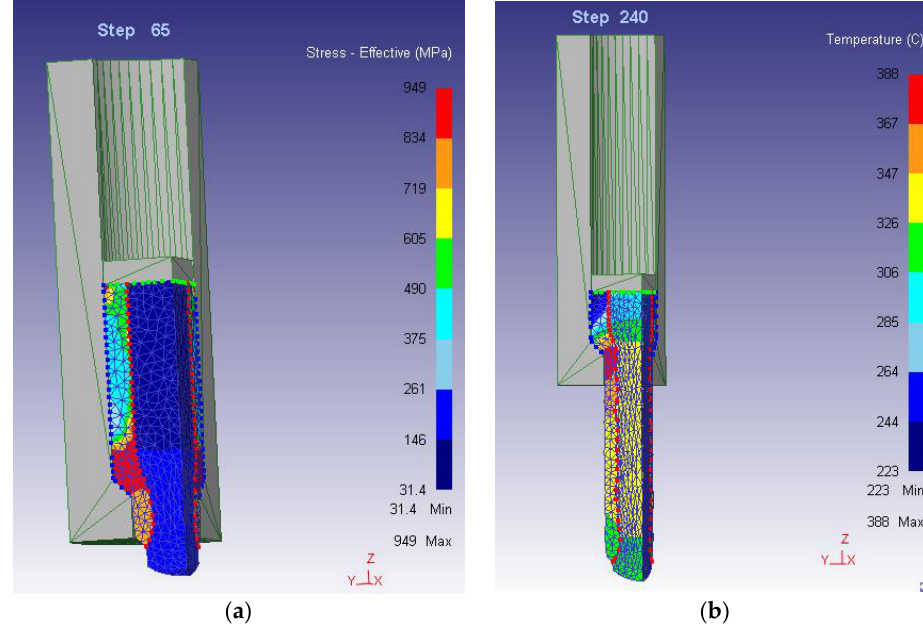
Figure 16. Contour diagrams. ( a ) Effective stress distribution during co-extrusion process; ( b ) temperature distribution during co-extrusion process.